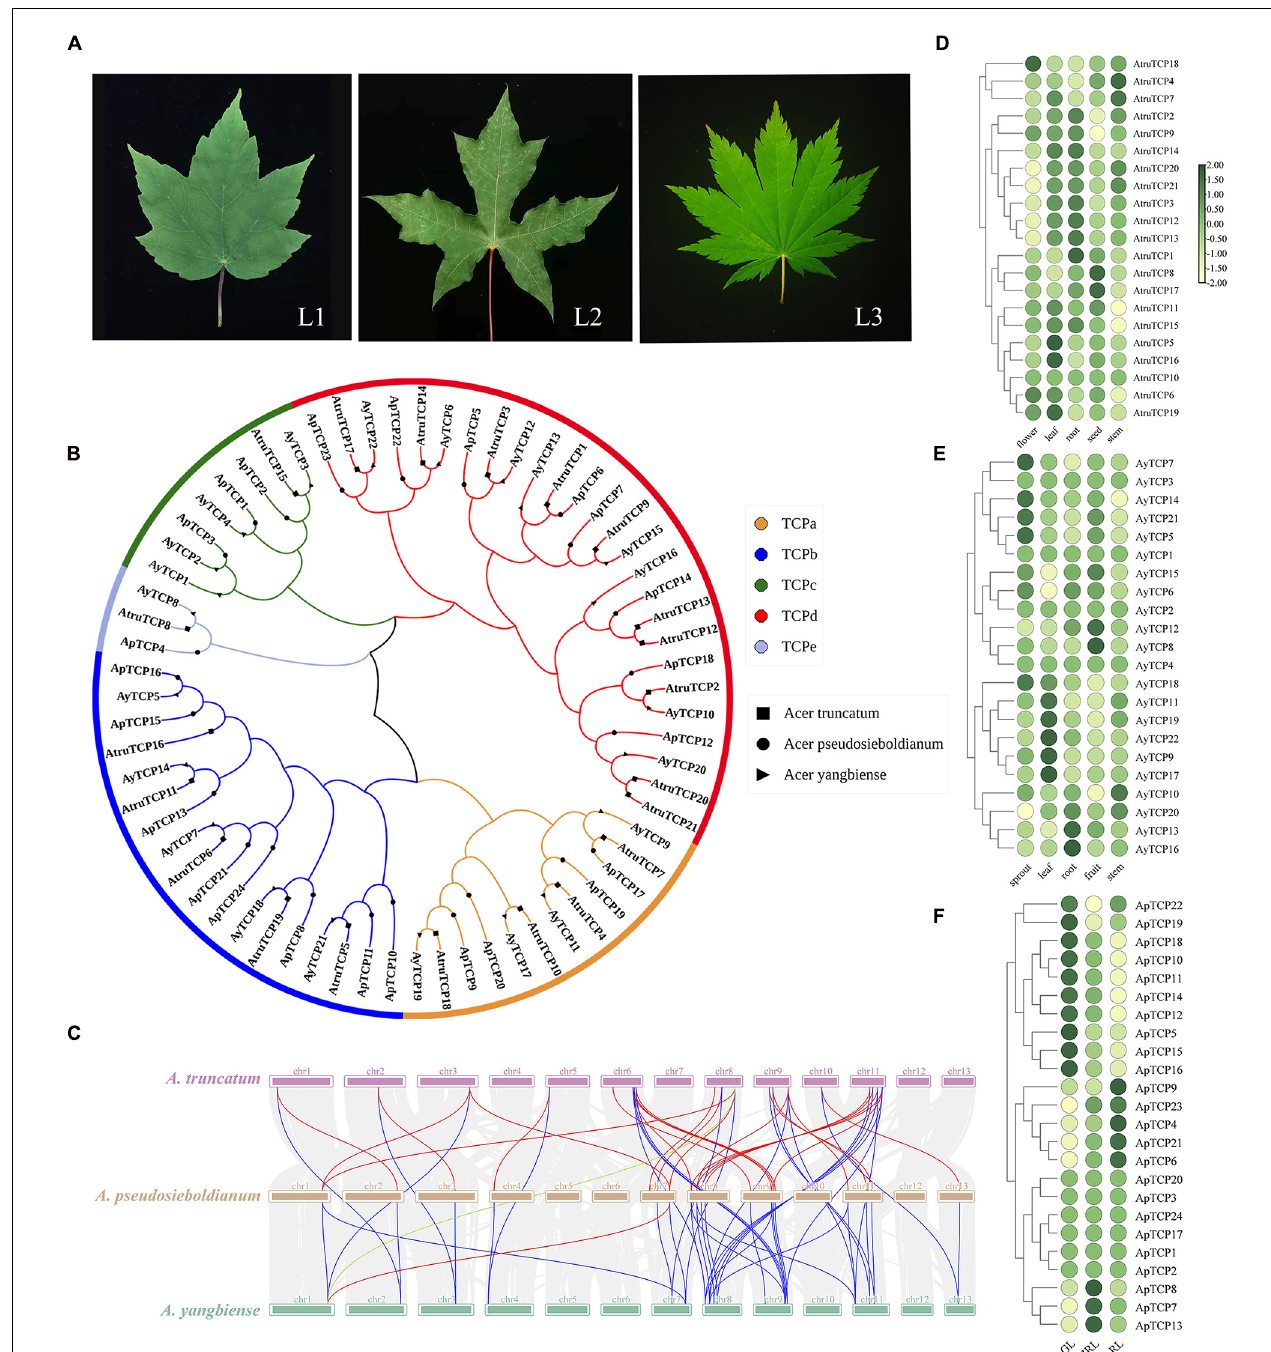
FIGURE 6 | Teosinte branched1, cycloidea, and proliferating cell factors (TCP) gene family in A. pseudosieboldianum , A. yangbiense, and A. truncatum . and expression analysis of TCP genes in different tissues. (A) Photographs of leaf shape in A. yangbiense , A. truncatum, and A. pseudosieboldianum . L1 represents the mature leaf in A. yangbiense ; L2 represents the mature leaf in A. truncatum ; L3 represents the mature leaf in A. pseudosieboldianum . (B) Phylogenetic tree of TCP genes from A. pseudosieboldianum (24 genes), A. yangbiense (22 genes), and A. truncatum (21 genes). (C) Synteny analysis of TCP genes